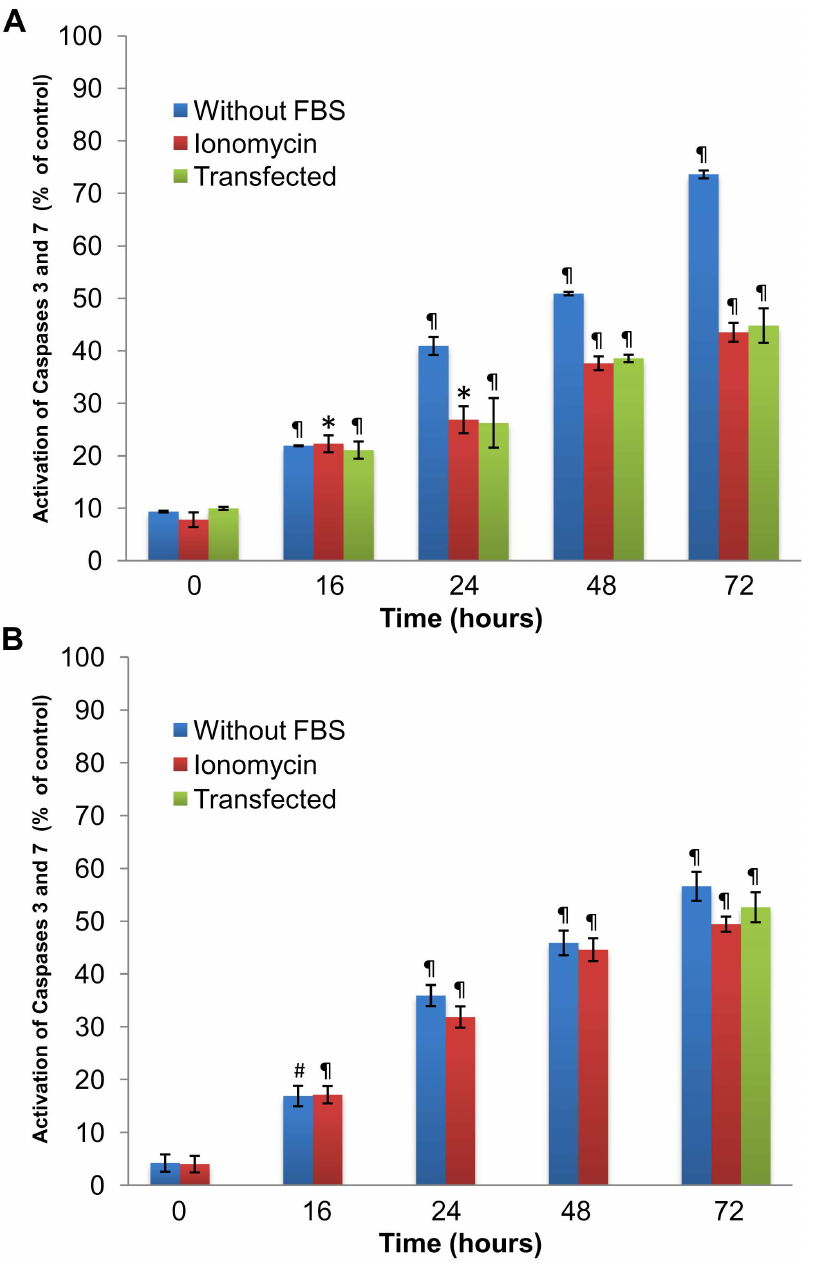
Figure 3. Activity of caspases 3 and 7. Caspase activity was determined using a fluorometric assay employing Z-DEVD-AFC as a substrate. ( A ) CHO cells grown in the absence of serum, transfected with arp2 cDNA or incubated with 10 m M ionomycin assayed at 16, 24, 48 and 72 h timepoints. ( B ) LNCaP cells grown in the absence of serum, transfected with arp2 cDNA (72 h) or incubated with 10 m M ionomycin assayed at 16, 24, 48 and 72 h timepoints. Mean values are presented (n=3, X 6 S.E.M), # p , 0.05, * p , 0.01, " p , 0.001 compared to control